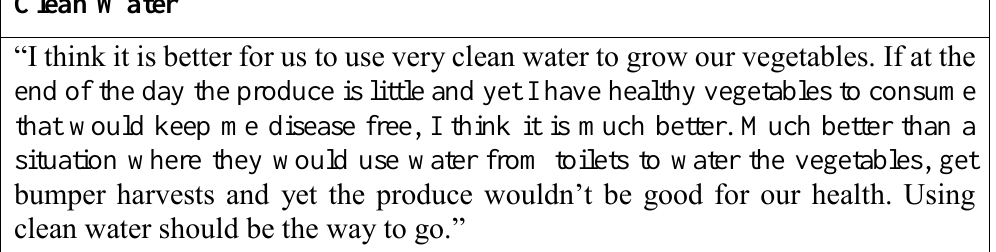
Table 3: Illustrative Excerpts from Small Group Discussions on Clean Water Clean